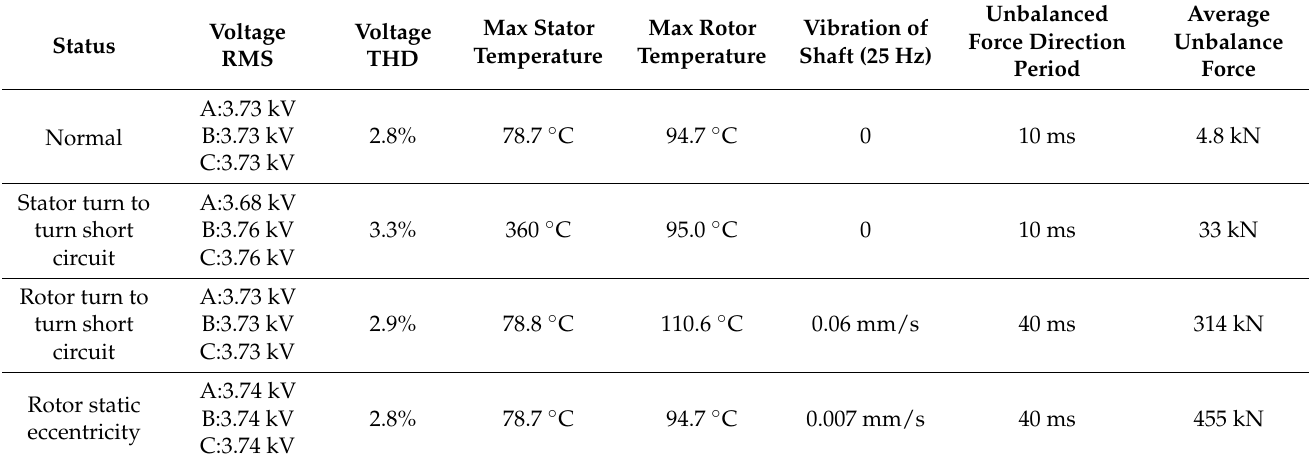
Figure 3. Vibration spectrum. Table 2. Signals of different statuses.